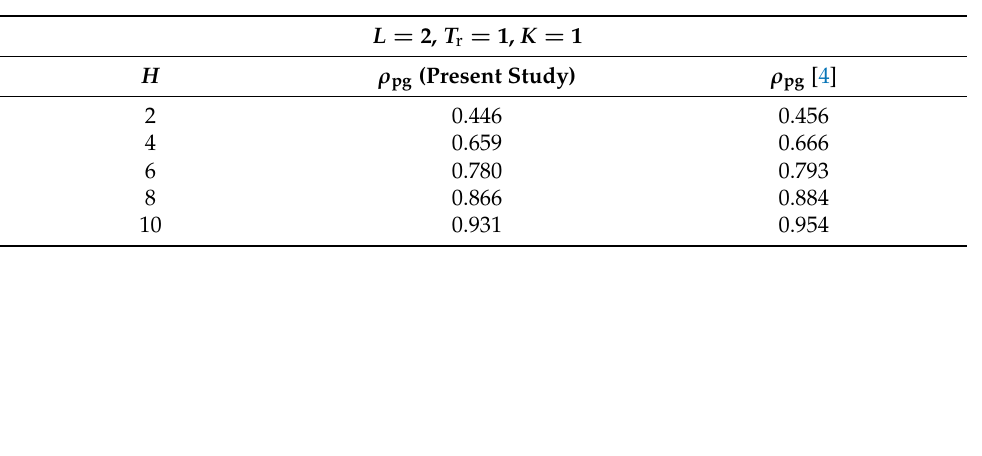
Table 2. Comparison of the present solutions with the data derived using the analytical solutions of Carlslaw and Jaeger [4] for a pair of buried pipes kept at the same